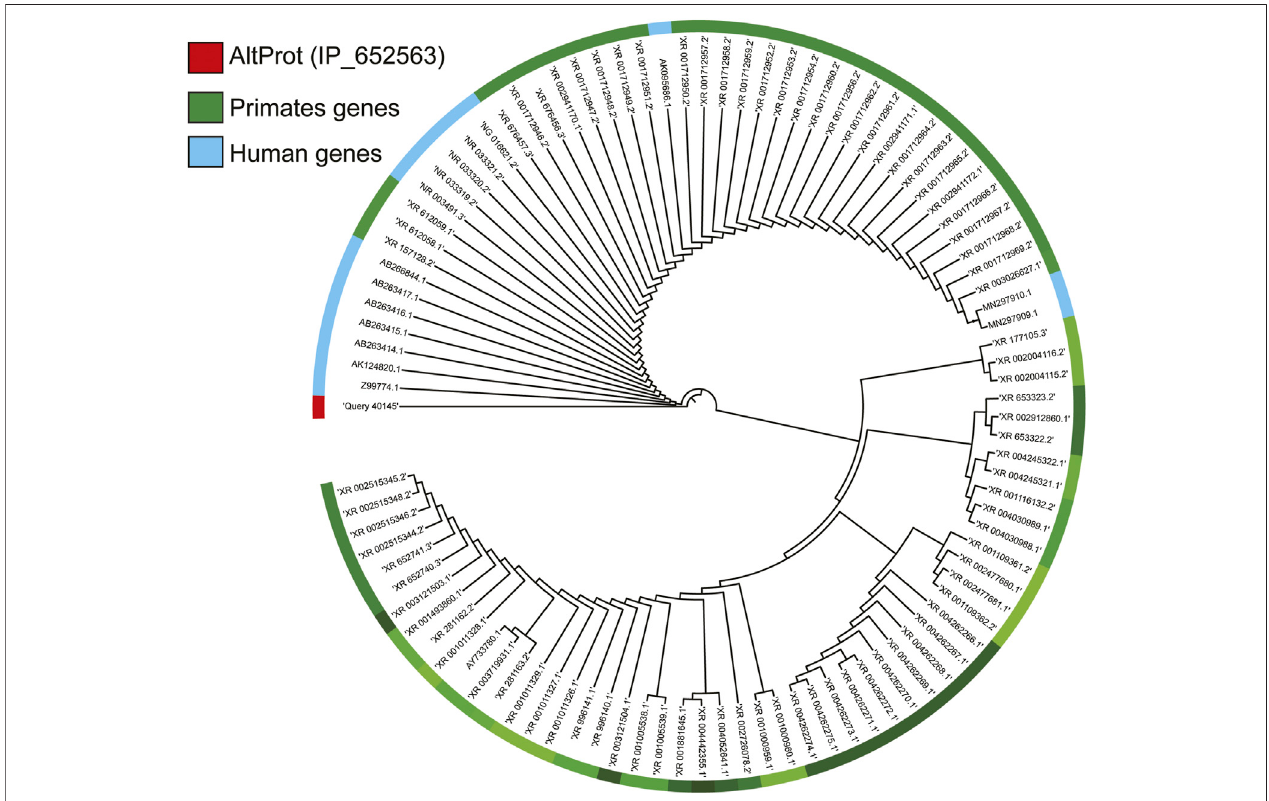
FIGURE 4 | Study of the phylogeny of AltProt (IP_652563 identi fi ed in the clinical study of GBM). Based on its sequence homology with the known and predicted proteome of all the mammalian species present on BlastP, the AltProt sequence is only found in primates. In blue, the nearby human genes that can encode this sequence, and in green, those of other